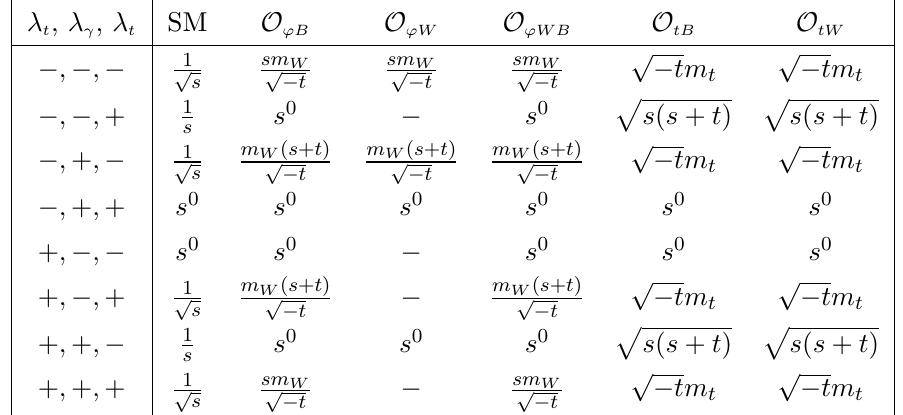
Table 18. Helicity amplitudes in the high-energy limit ( s Overall multiplicative factors are dropped and only the schematic energy dependence is retained for the SM contribution. Helicity entries marked by ‘ section 5.2.1 for a discussion of the results.